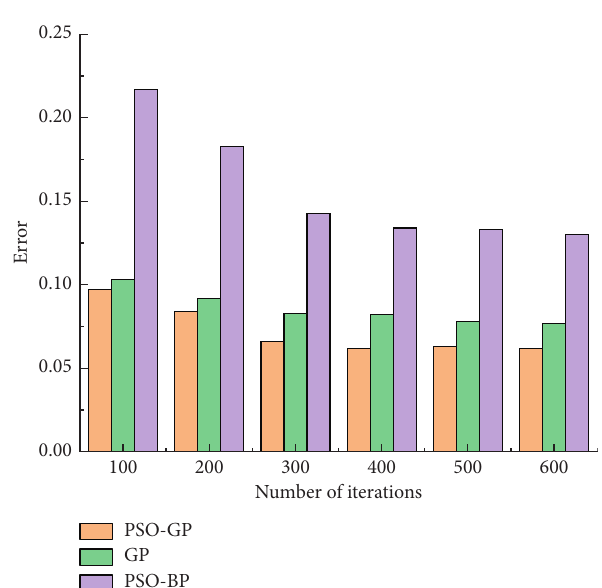
Figure 8: Comparison chart of different